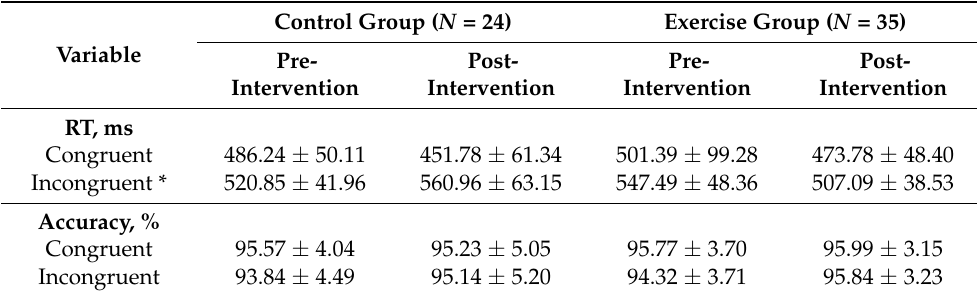
Table 2. Mean RTs and accuracy rates (M ± SD) in the Eriksen Flanker task by